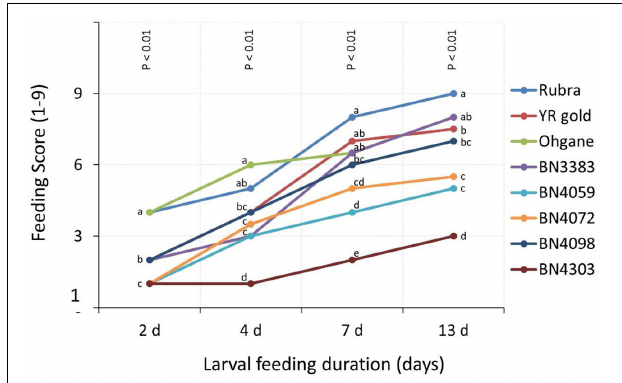
FIGURE 4 | Extent of insect damage on cabbage genotypes measured in terms of visual scores on a scale of 1–9, with ‘1’ being scored for the least and ‘9’ for the highest area damaged by Diamondback moth (DBM) larvae in eight genotypes of cabbage in glass-house experiment. The higher scores indicate a higher feeding preference of adult DBM on the cabbage genotypes. Data presented as median scores of eight observations. The range values are shown in Supplementary Table S2. Genotypes varied significantly for feeding scores ( p < 0.01) at each time points as determined by Non-parametric Mood’s Median test. Different letters across genotypes at each time points indicate statistically significant differences as per Bonferroni’s pairwise